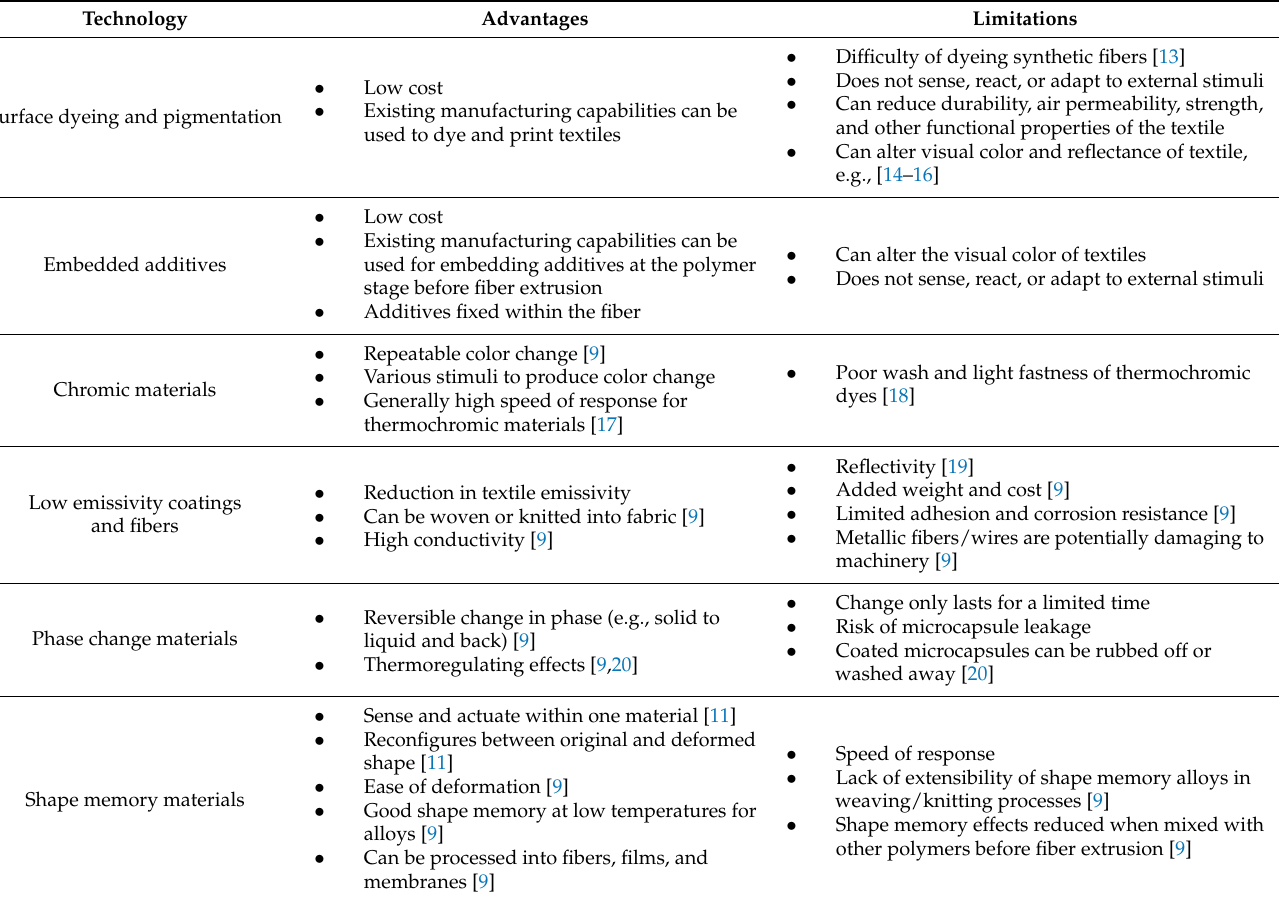
Table 1. Advantages and limitations of applying existing technologies in smart camouflage